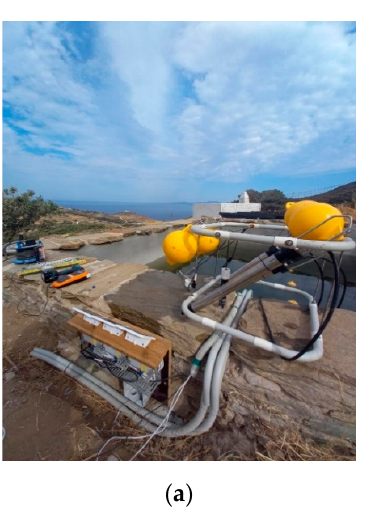
Figure 19. Installations of the system for water quality and quantity measurements in: ( a ) open cistern; ( b ) closed tank.